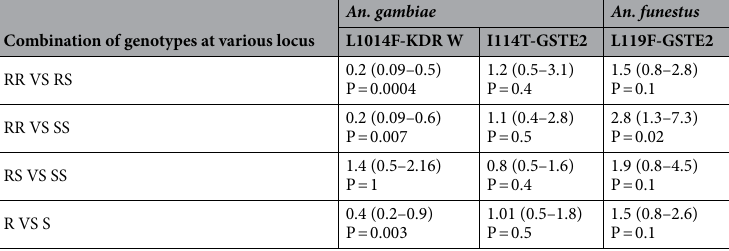
Combination of genotypes at various locus